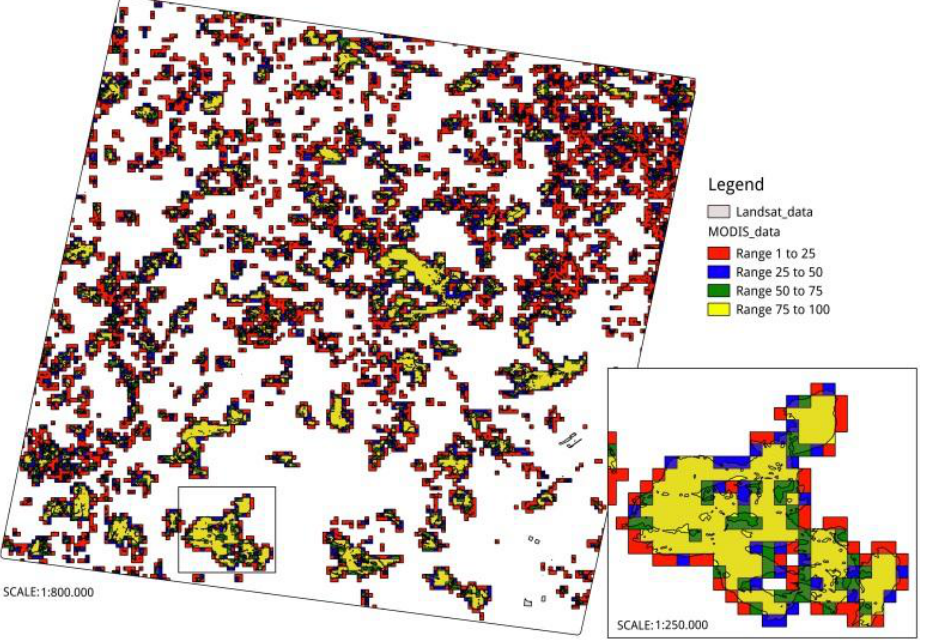
Figure 4. Medium resolution reference scars (Jalapão region, year 2005 (JA)), represented by black lines and respective percentages of burned areas for MODIS pixels of 1 km, where red pixels denote percentages below 25%, blue pixels between 25% and 50%, green pixels between 50% and 75%, and yellow above 75%. Small panel: zoom of the area, superimposed by the vectors of the scars as derived from Landsat reference maps (black